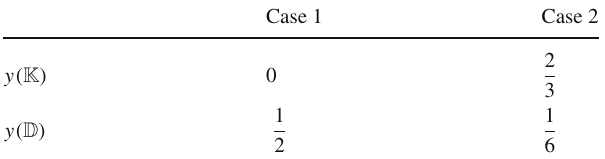
Table 9 Values of the U ( 1 ) (cid:2) charges for the SM matter in U μν SSM models using solution (29) with the exotic quarks ˆ K 1 , 2 , 3 and ˆ K c , − 1 . These values are independent of thesolutions fixing z ( H d ) = 0 , 1 2 2 for z ( F ) , with F denoting the exotic quarks